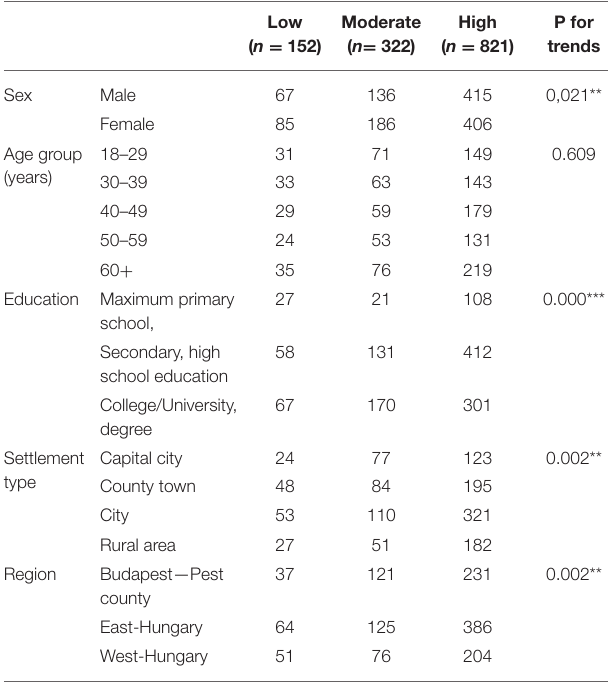
TABLE 2 | The association between physical activity and personal/socio-demographic characteristics of the sample.